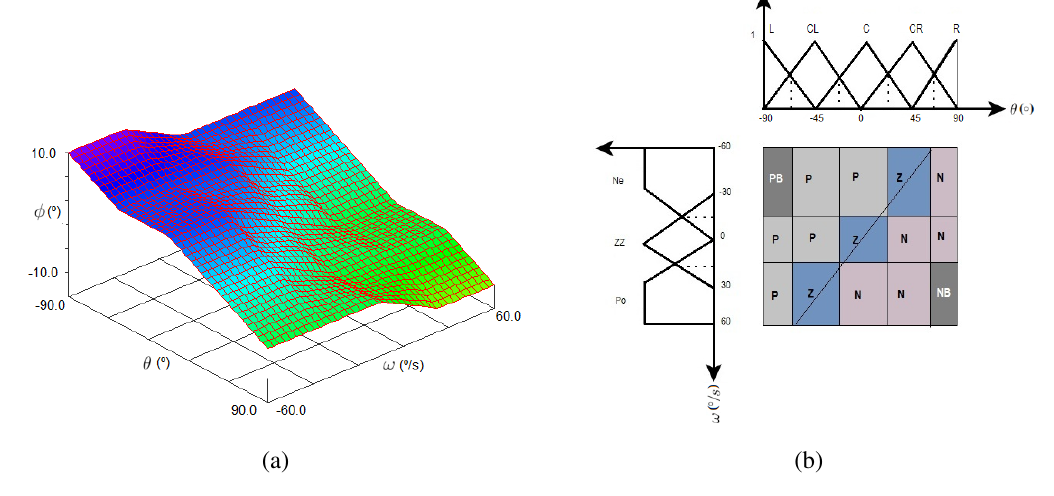
Figure 7. 3D output surface and states space. ( a ) 3D output surface obtained with XFuzzy tools. ( b ) States space and transition